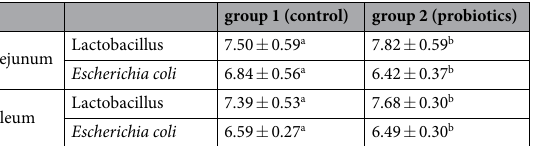
Table 3. Microbial enumeration (log cfu/g of wet digesta; mean ± SD). a,b Different letters within rows indicate differences between treatment groups ( p <